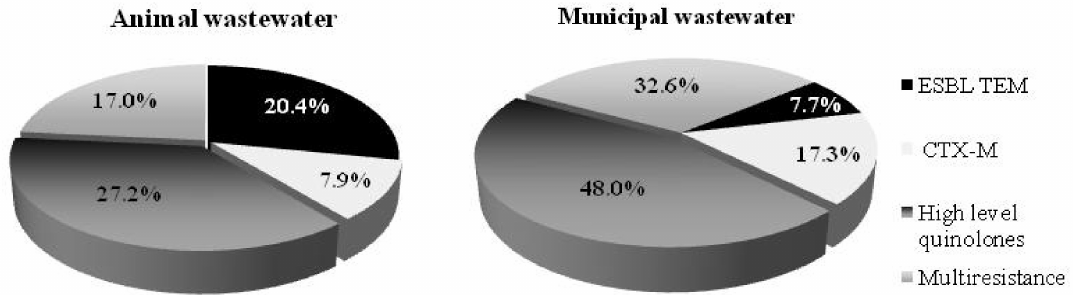
Figure 3. Phenotype resistance of E. coli isolates from the animal and municipal wastewater treatment plants.